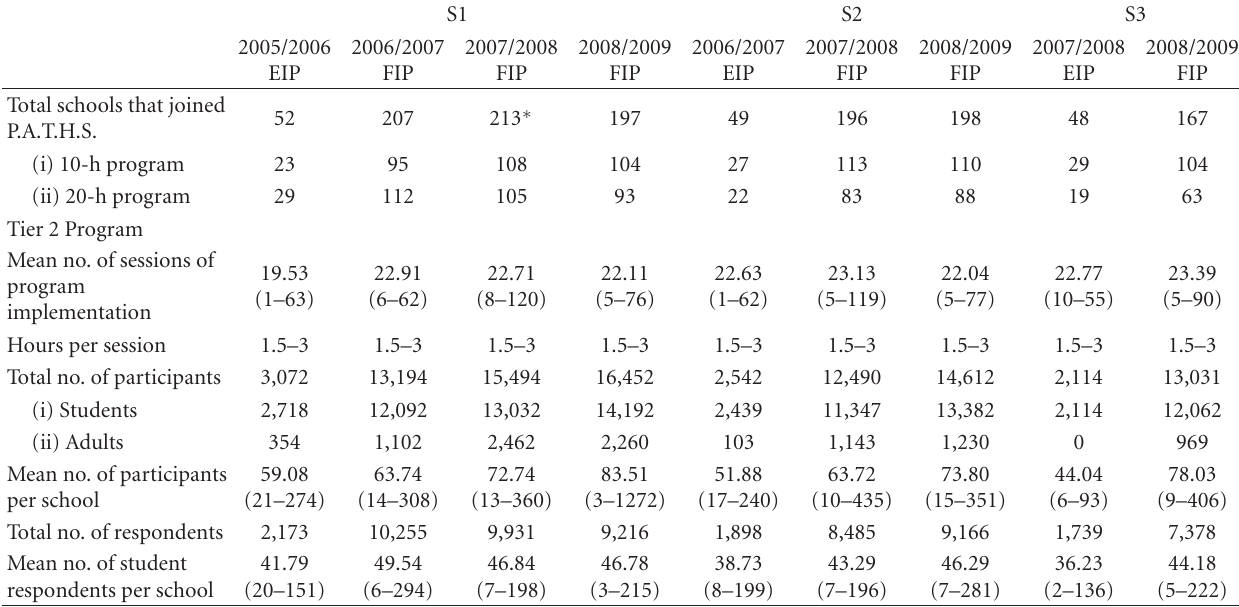
Table 1: Description of data characteristics from 2005 to